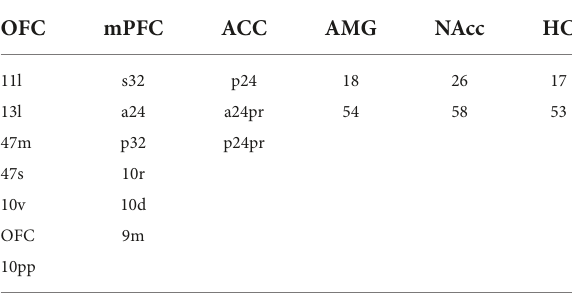
TABLE 2 List of parcels from the HCP_MMP1.0 atlas and the subcortical ROIs from FSL’s FIRST segmentation combined to form the six ROIs for the fronto-limbic